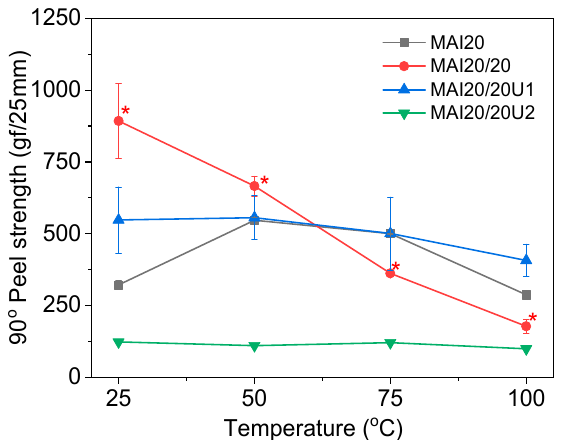
Figure 12. 90° peel strength of the SiUDMA-modified MAI20 series as a function of temperature. The red asterisk denotes cohesive failure.